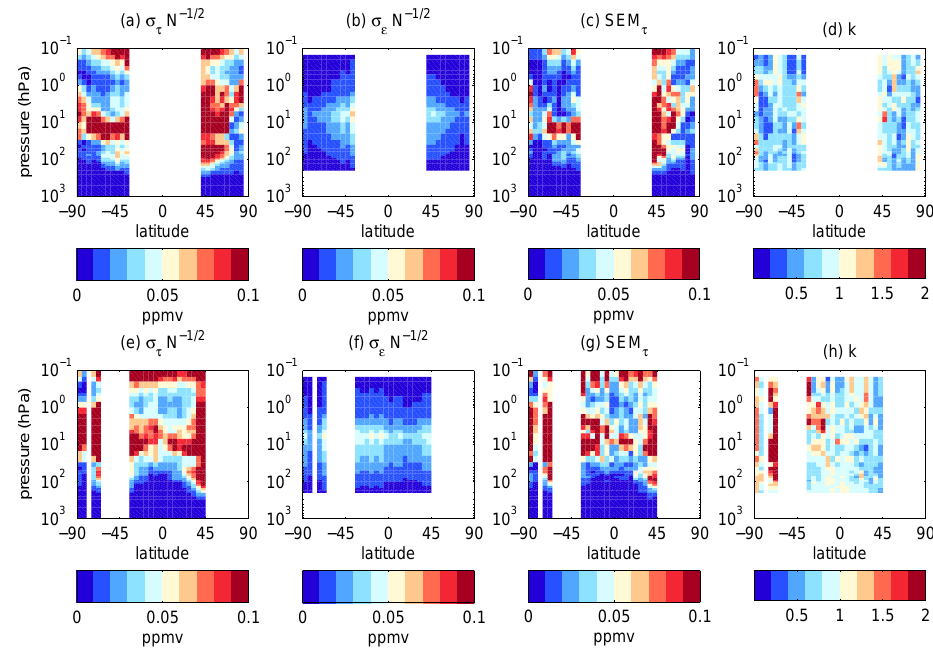
√ N , the single-sample estimate of the natural variability component of the Fig. 7. Pressure latitude sections of zonal mean values of σ τ / √ N , the random measurement error component of the SEM (second column); the empirically derived SEM τ (third SEM (first column); σ (cid:15) / column) and k as defined in text (fourth column) based on ACE-FTS sampling of CMAM March (top) and April (bottom) O 3